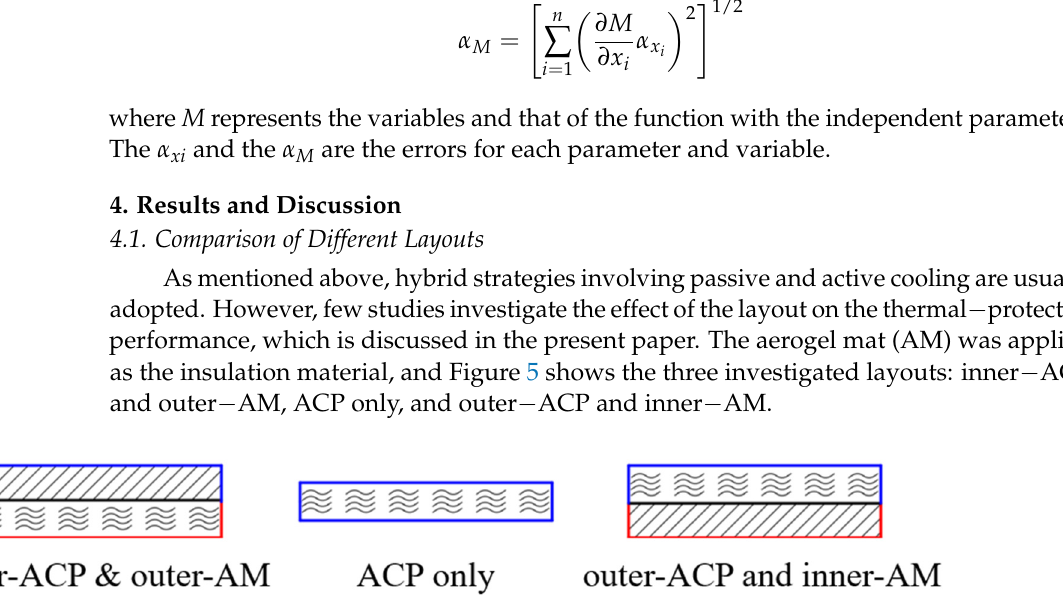
Figure 5. Diagram of cases with different ACP layouts.